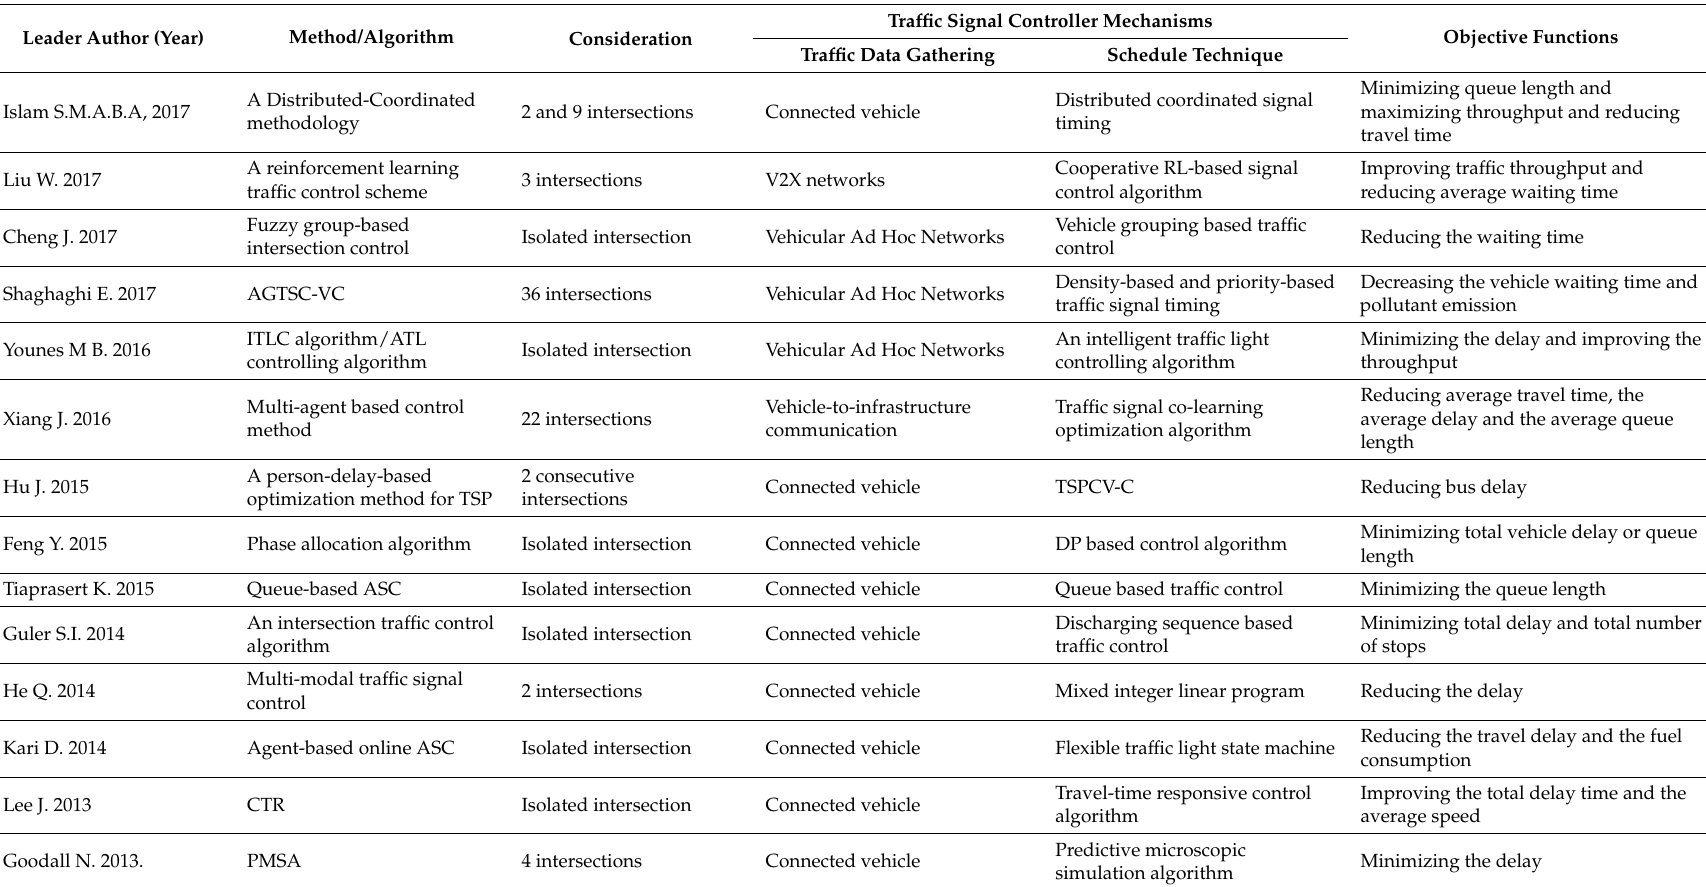
Table 3. Summary of methods of adaptive traffic signal control utilized in selected